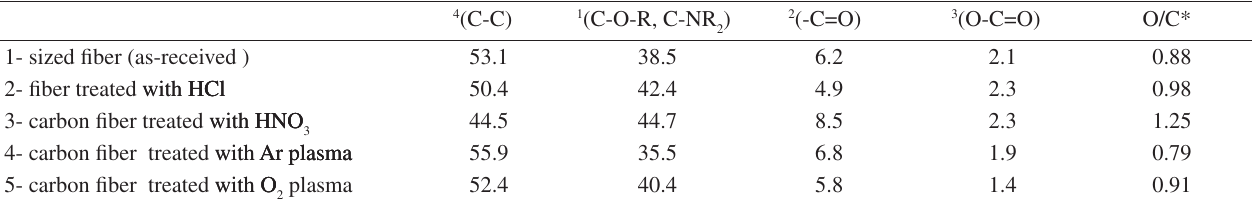
Table 4. Percentage of chemical groups revealed by XPS analyses of untreated and treated carbon